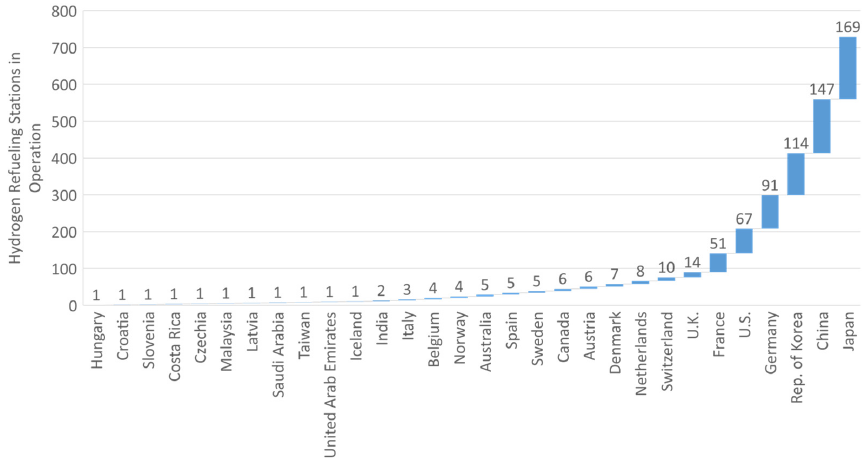
Figure 7. Waterfall diagram showing the breakdown of hydrogen refueling stations as of the end of 2021 worldwide.